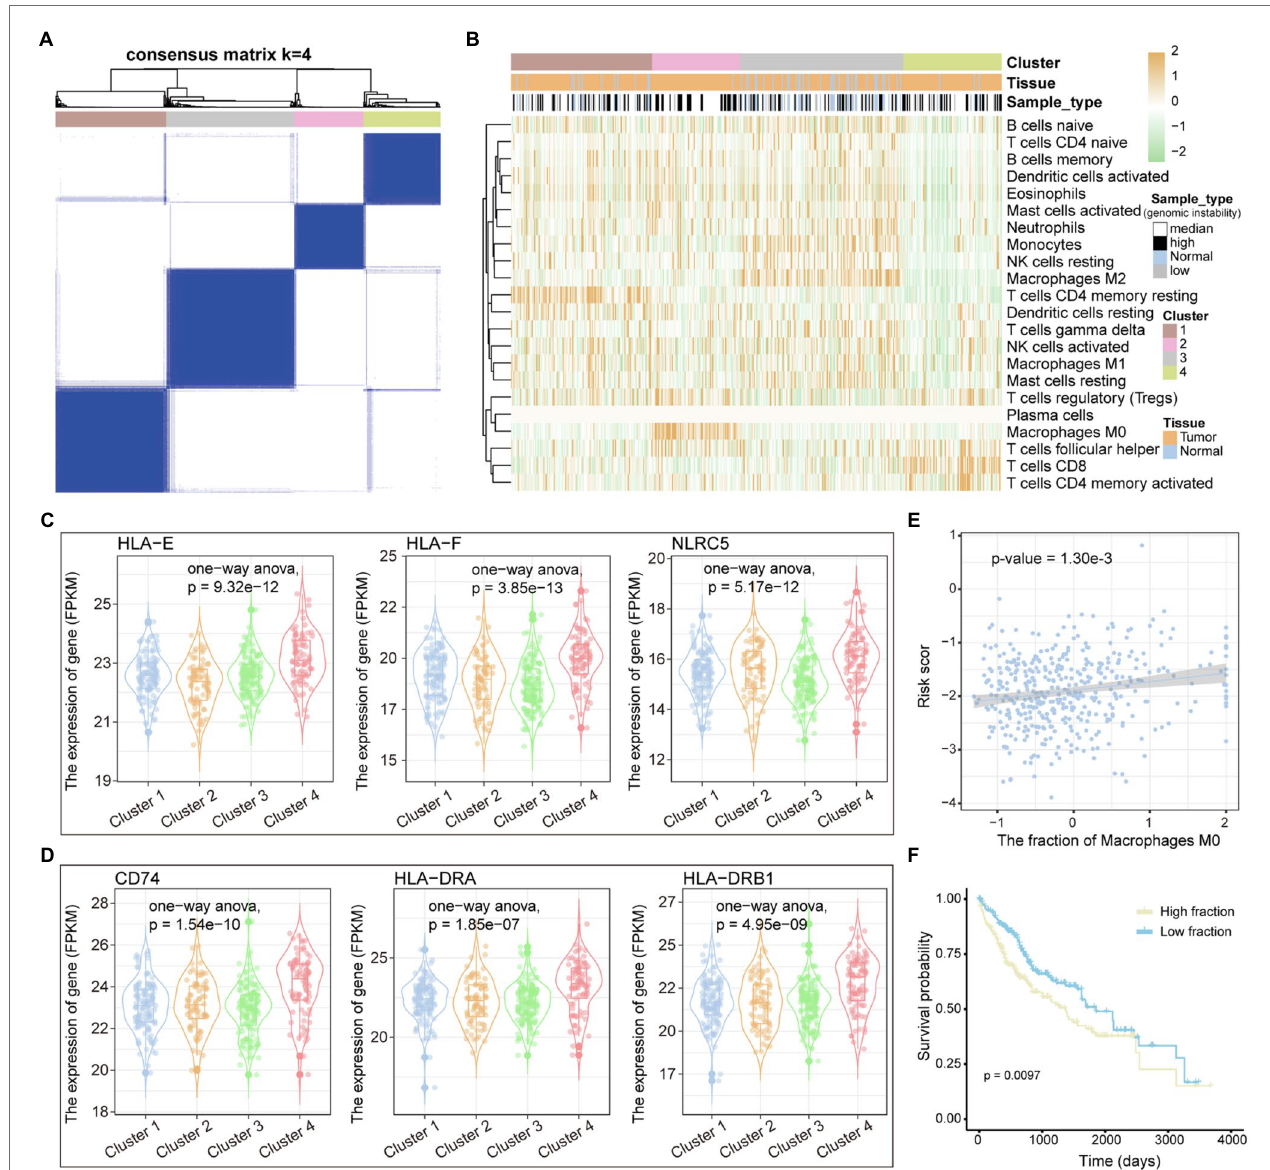
FIGURE 5 | Immune cell components of LIHC patients. (A) The samples are divided into several clusters based on the immune cell components of each sample. The consistency matrix is drawn as a heat map, and the column labels show the clusters. (B) The 22 immune cell fractions of each sample were displayed by heat map. Column labels, including clusters, tissue origin, and type of variation of samples, are displayed. (C,D) The relationship between genes encoding MHC I and MHC II molecules and clusters defined by immune cell components is shown by boxplot. ANOVA is used to calculate statistical significance. (E) The correlation between the fraction of macrophages M0 and the risk score is shown. (F) KM curves for survival in high and low fraction groups of macrophages M0. Log-rank test is used to calculate statistical